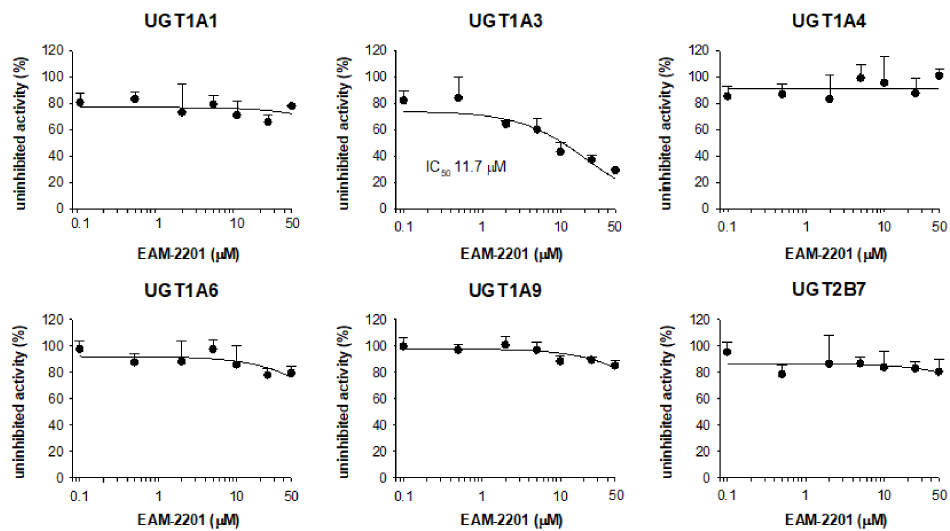
Figure 4. The inhibitory effects of EAM-2201 on the activities of six uridine 5 (cid:48) -diphospho- glucuronosyltransferases (UGT) enzymes in ultrapooled human liver microsomes. The cocktail UGT substrate concentrations were as follows: 0.5 µ M SN-38 for UGT1A1, 2 µ M chenodeoxycholic acid for UGT1A3, 0.5 µ M trifluoperazine for UGT1A4, 1 µ M N -acetylserotonin for UGT1A6, 0.2 µ M mycophenolic acid for UGT1A9 and 1 µ M naloxone for UGT2B7. The data are presented as the mean ± SD ( n = 3).